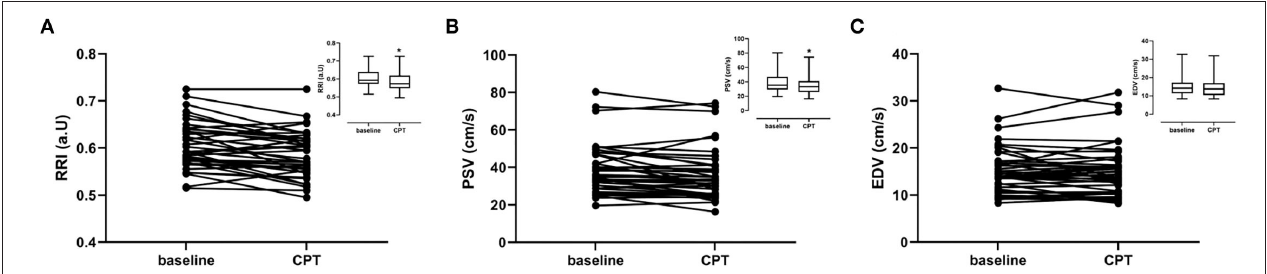
FIGURE 3 | Renal ultrasound parameters per subject for baseline and cold pressor test (CPT). Graph inserts are the mean values ± SD. (A) Renal resistivity index (RRI) (B) Peak Systolic Velocity (PSV). (C) End diastolic velocity (EDV).